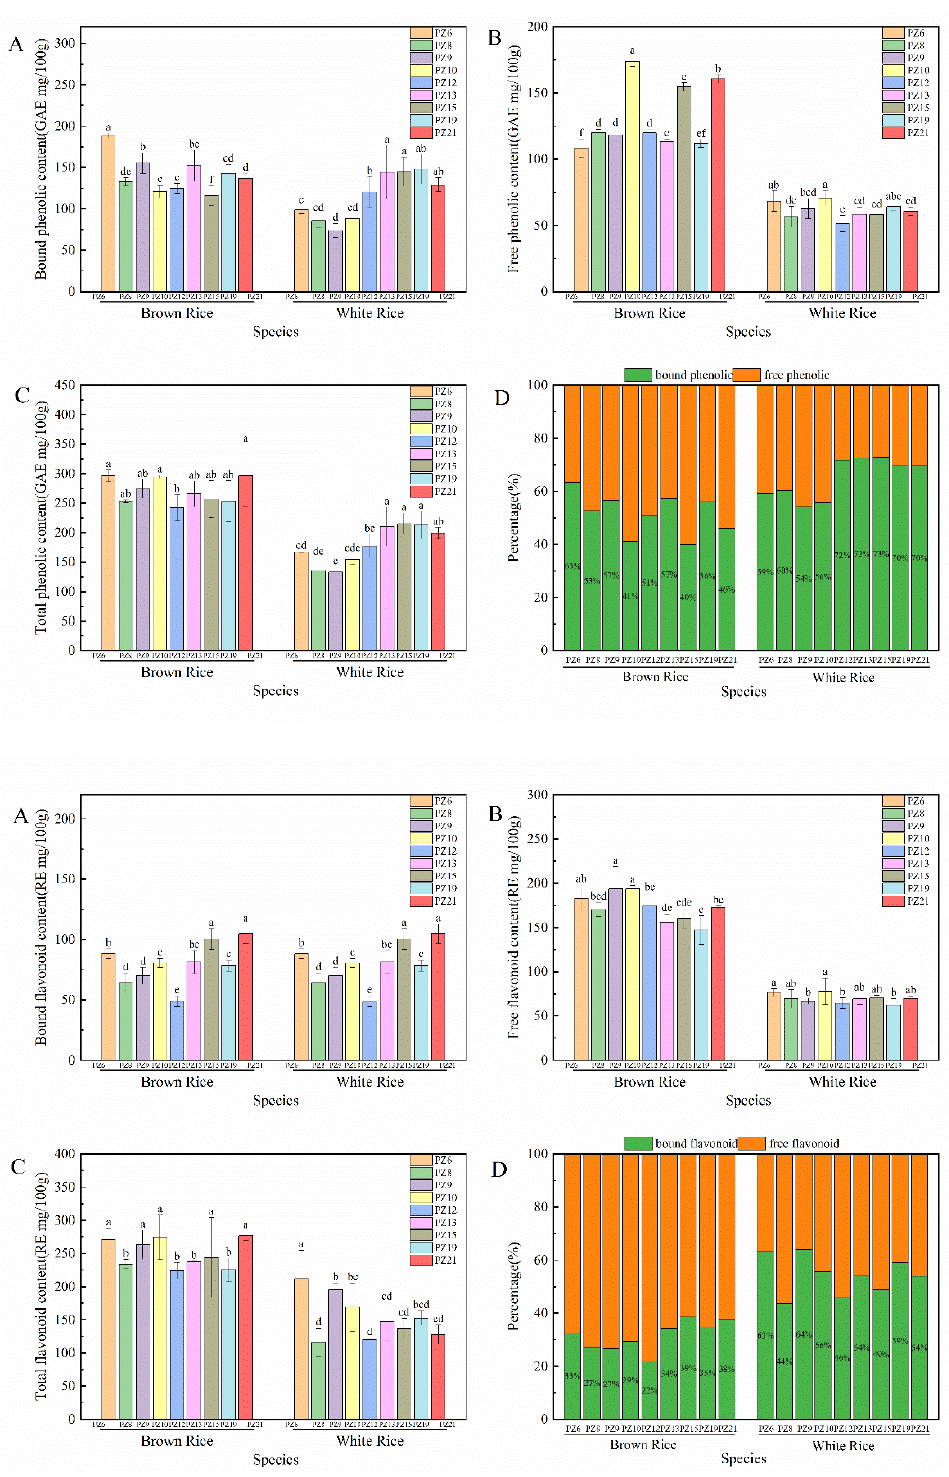
Figure 1. Bound, free, and total phenolic and flavonoid content of japonica rice varieties (( A ): Bound phenolic and flavonoid; ( B ): Free phenolic and flavonoid; ( C ): Total phenolic and flavonoid). Percentage bound phenolic and flavonoid content out of the total content ( D ). Values of each bar with lowercase letters in common are significantly different ( p < 0.05).